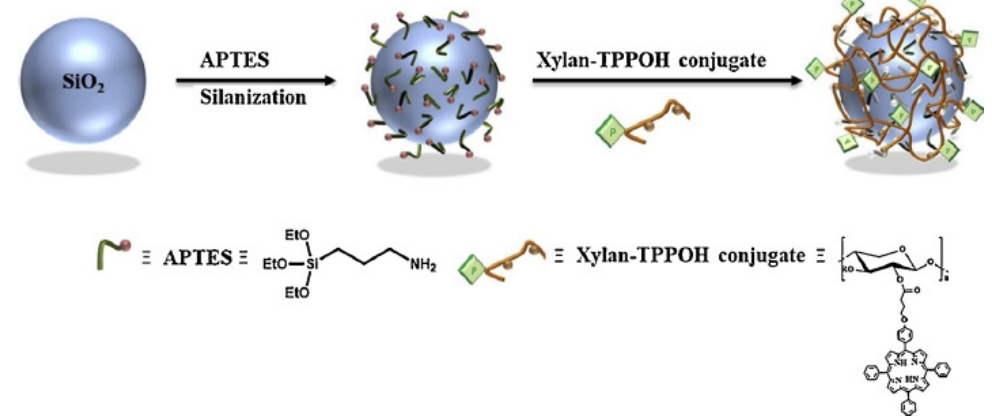
Figure 16. General procedure for the synthesis of PX SNPs. SIO 2 : silicon dioxide [97].